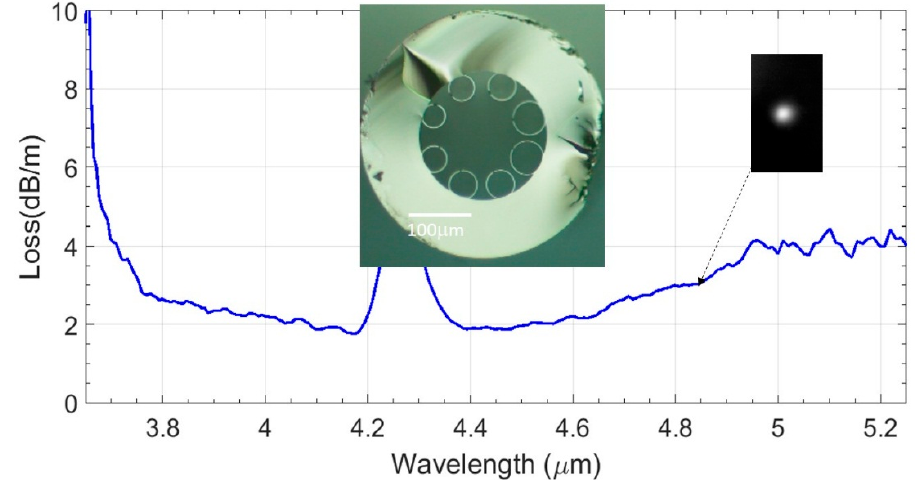
Figure 4. Attenuation spectrum for the HC optical fiber shown in the inset. The attenuation between 5 and 5.2 μ m is 4 dB/m. The inset on the right-hand side shows the optical mode image within the wavelength range 4.75–4.9 μ m.